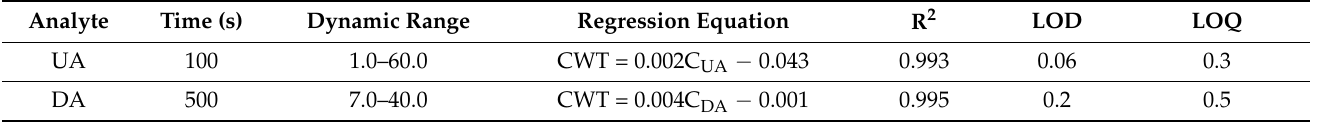
Table 2. Statistical results of calibration graphs obtained at zero-crossing points using CWT-db4. Analyte Time (s) Dynamic Range Regression Equation R